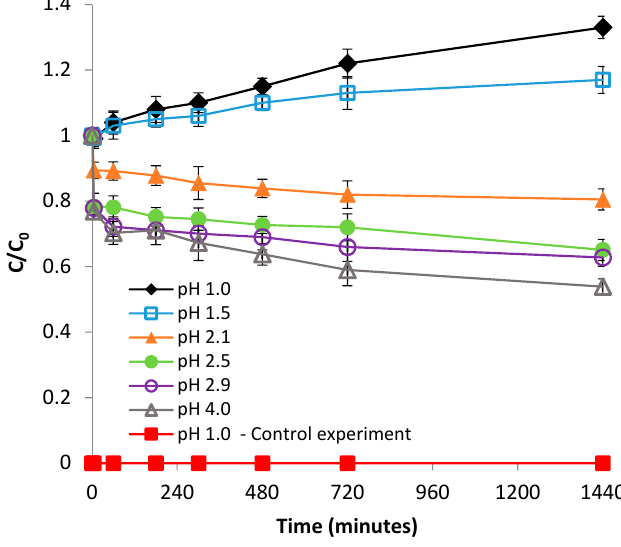
Figure 1. Effect of pH on Fe(II) removal by bentonite.